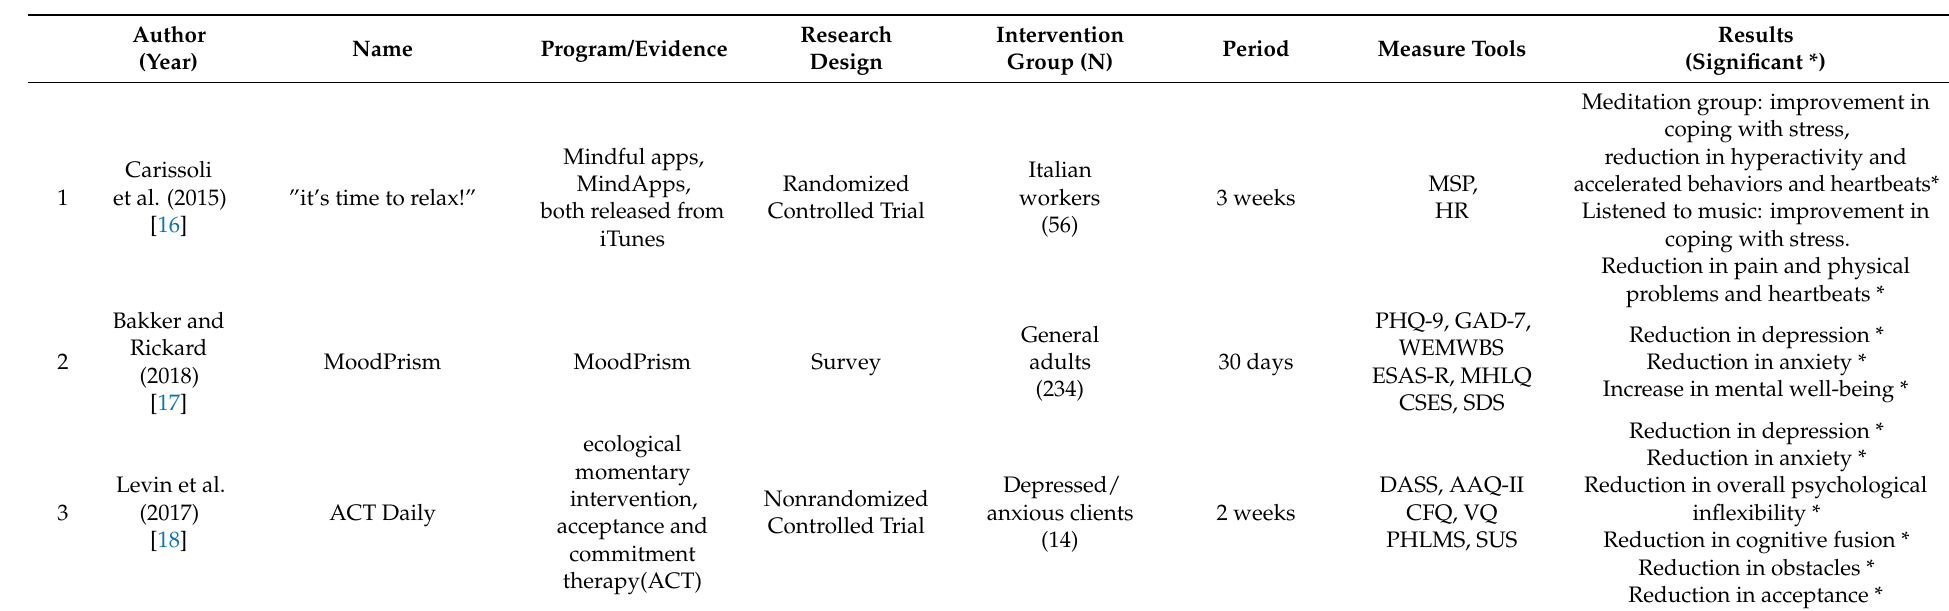
Table 3. Characteristics and outcomes of selected 14